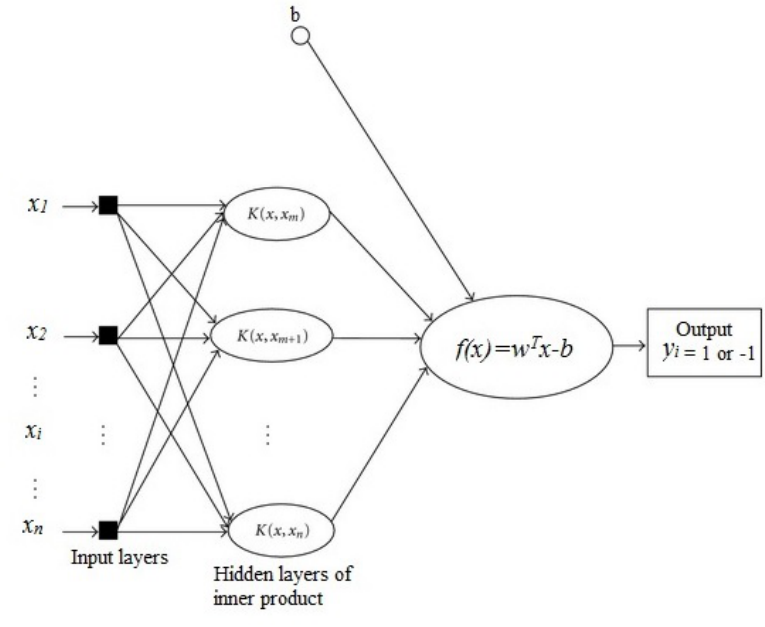
Figure 5. Predicting y i support vector machine